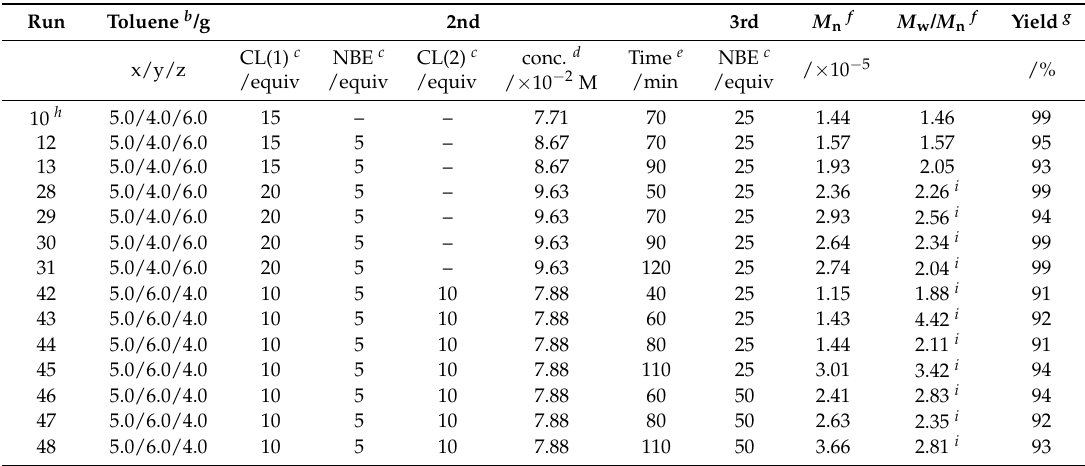
Table 3. Synthesis of star-shaped polymers by living ring-opening metathesis polymerization